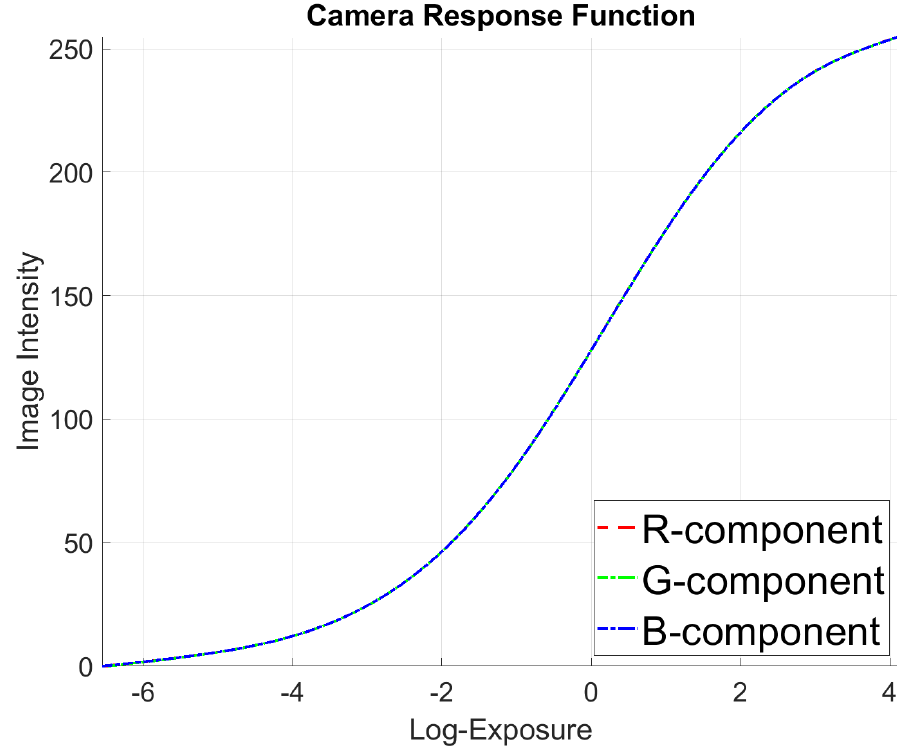
Figure 7. The Camera Response Function (CRF) curve calculated with images of different exposure time in the same static